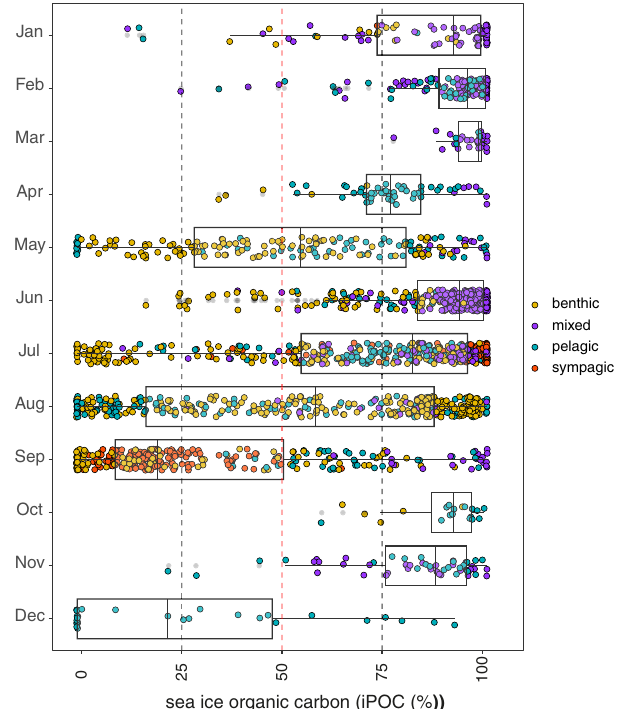
Fig. 3 | Seasonal sea ice particulate organic carbon (iPOC) content of Arctic consumers relative tophytoplankton. Monthly sampling-date binned HBI-based estimates of sea ice carbon content for all individuals with month recorded ( n =1940) and sampled between 1982 – 2019. Box plots display the fi rst to third quartiles with the vertical line representing the median values and the whiskers extend to the minimum and maximum values. Data points are individual samples and are colored to represent their assigned habitat [benthic, mixed, pelagic, and